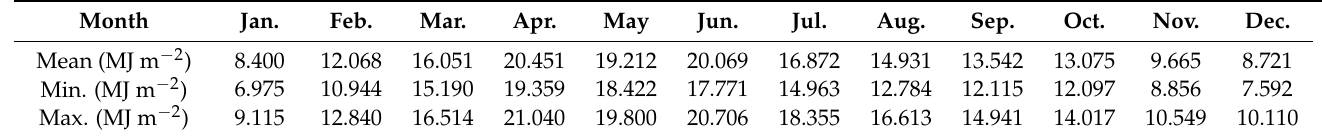
Figure 12. The distribution of monthly mean daily SSI, from 1 January 2020 to 31 December 2021, estimated from GK2A/AMI using the CNN approach with respect to different administrative districts around Korea in ( a ) January, ( b ) February, ( c ) March, ( d ) April, ( e ) May, ( f ) June, ( g ) July, ( h ) August, ( i ) September, ( j ) October, ( k ) November, and ( l ) December. Table 3. Mean, minimum, and maximum values of monthly mean daily GK2A/AMI SSI considering administrative district around Korea from 1 January 2020 to 31 December 2021, where Mean, Min., and Max. indicate mean value, minimum value, and maximum values, respectively.